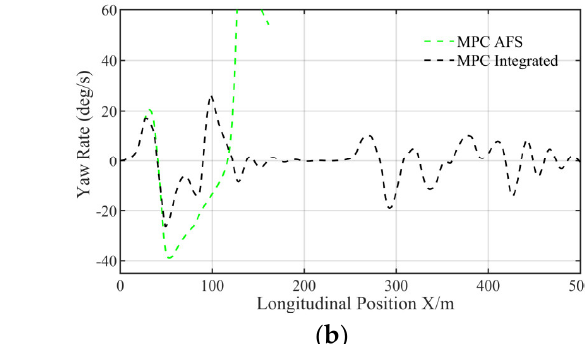
Figure 15. Comparison of ( a ) longitudinal velocity and ( b ) yaw rate at higher speed ( V x = 110km/h).